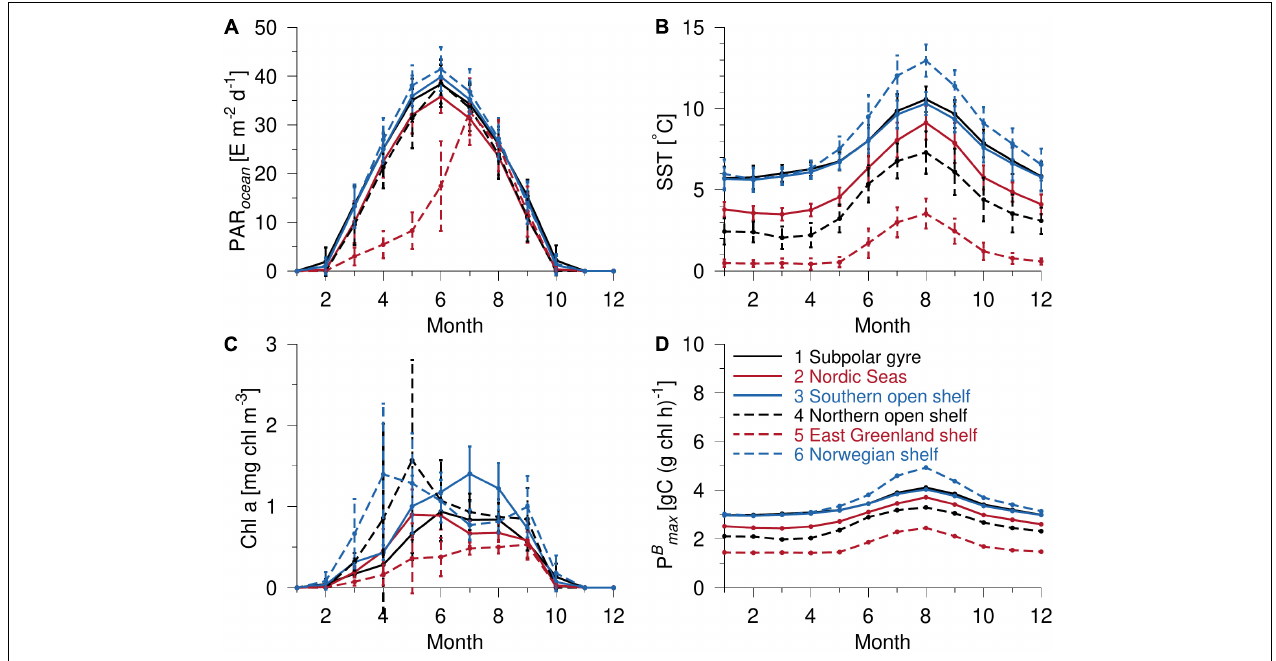
FIGURE 5 | Monthly averaged values (with standard deviation) for the six subdomains in the 2003–2013 period for (A) PAR, (B) SST, (C) chlorophyll a, and (D) P B max .